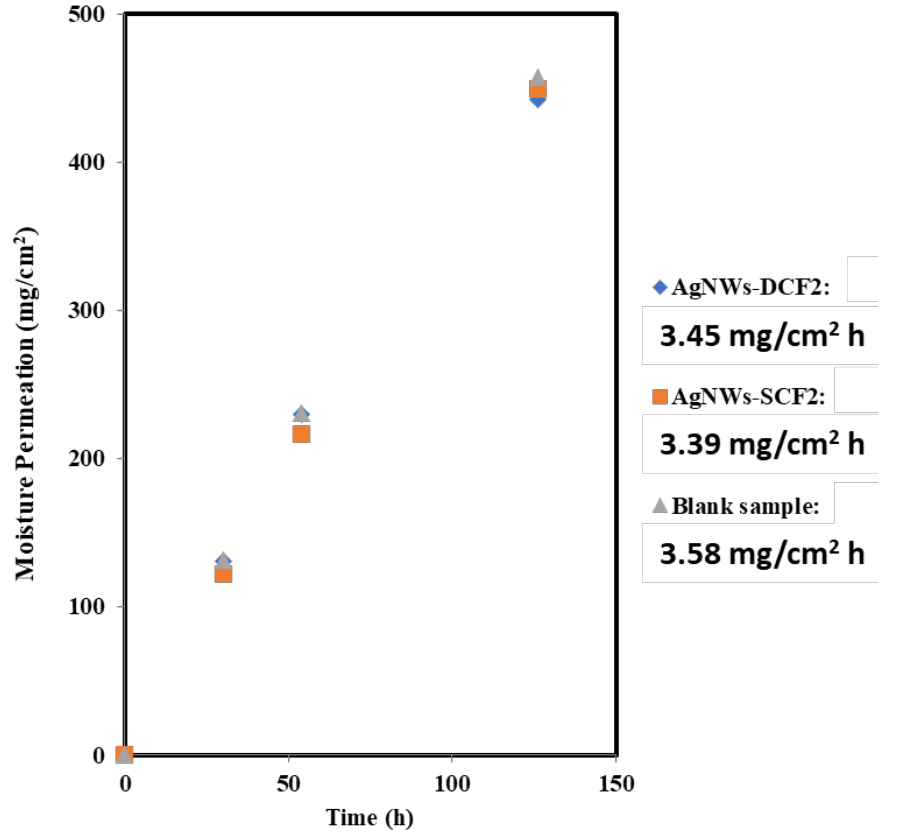
Figure 5. Moisture permeation of samples vs. time for blank and coated sample with dip- and spray-coating methods.